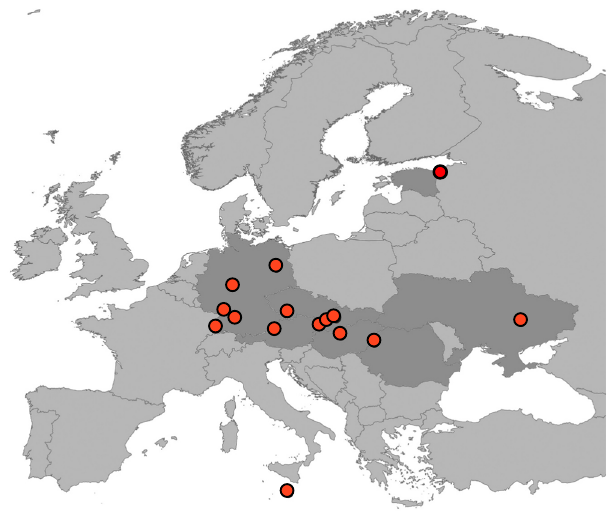
Fig. 1 Map of Europe, highlighting stable wild marbled cray fi sh populations, as described in this study. The map was generated with QGIS 3.2.0, locations of speci fi c populations are indicated by red dots (see Supplementary Table S1 for